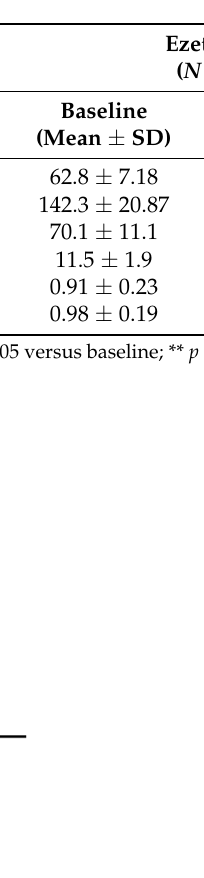
Table 3. Pre-treatment and 2-month follow-up hemodynamical data of enrolled patients.